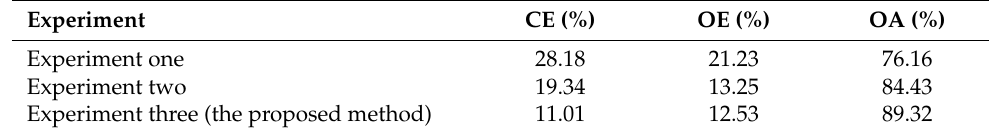
Table 4. Accuracy rates of experiment one, experiment two, and experiment